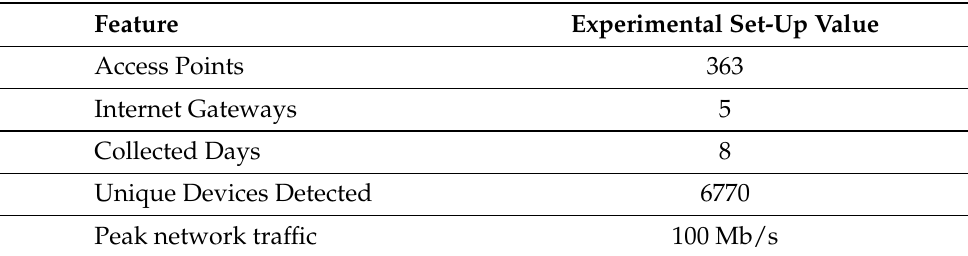
Table 1. Experimental set-up features. The large-scale wireless network accounts for up to 5000 con- current users and serves more than 60,000 users in